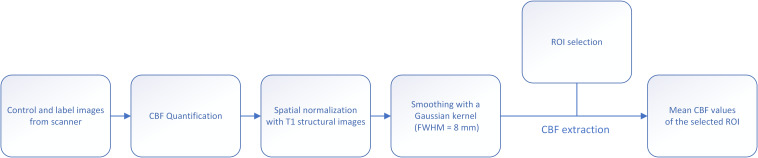
Flow chart of imaging preprocessing, segmentation and CBF extraction.